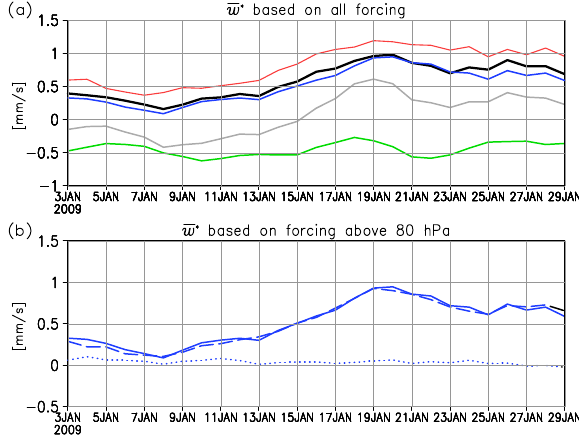
Fig. 3. Time-altitude section of the residual mean vertical wind (mms − 1 ; color shadings and contours) based on all forcing. (a) Observation, (b) forcing in all regions, (c) forcing in the global stratosphere, and (d) forcing in the global troposphere. Contour interval is 0.2 mms − 1 . See Table 1 for detail.